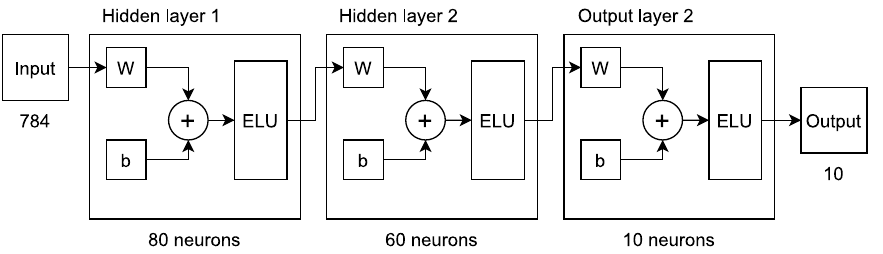
Figure 6. Digit classification ANN